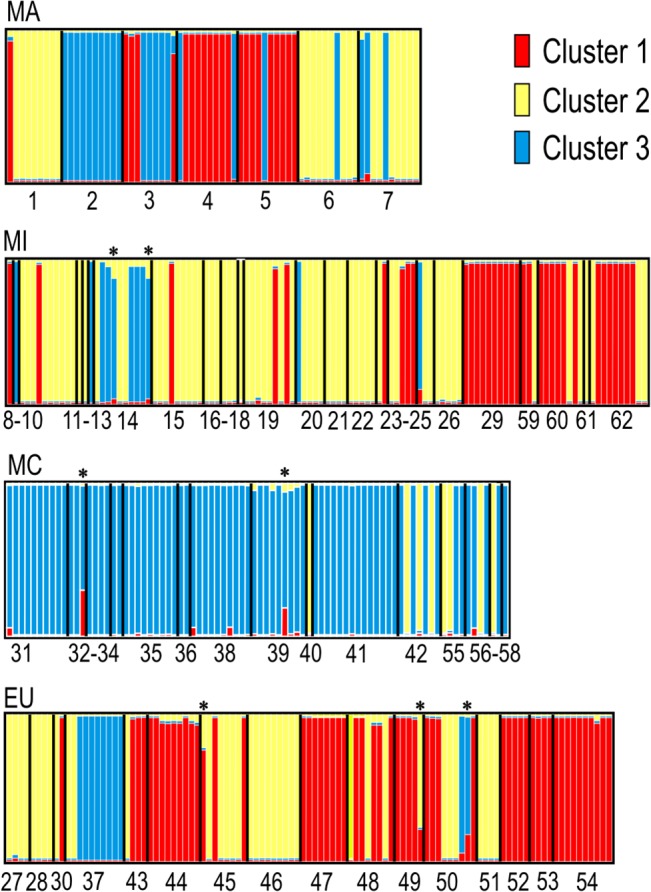
Inferred ancestry of individuals of Parmelina tiliacea from each site grouped by geographical areas.Collection sites numbered as in S1 Table. Each individual is represented by a single vertical line, broken into colored segments with lengths proportional to each of the three inferred clusters. Admixed individuals marked with an asterisk.